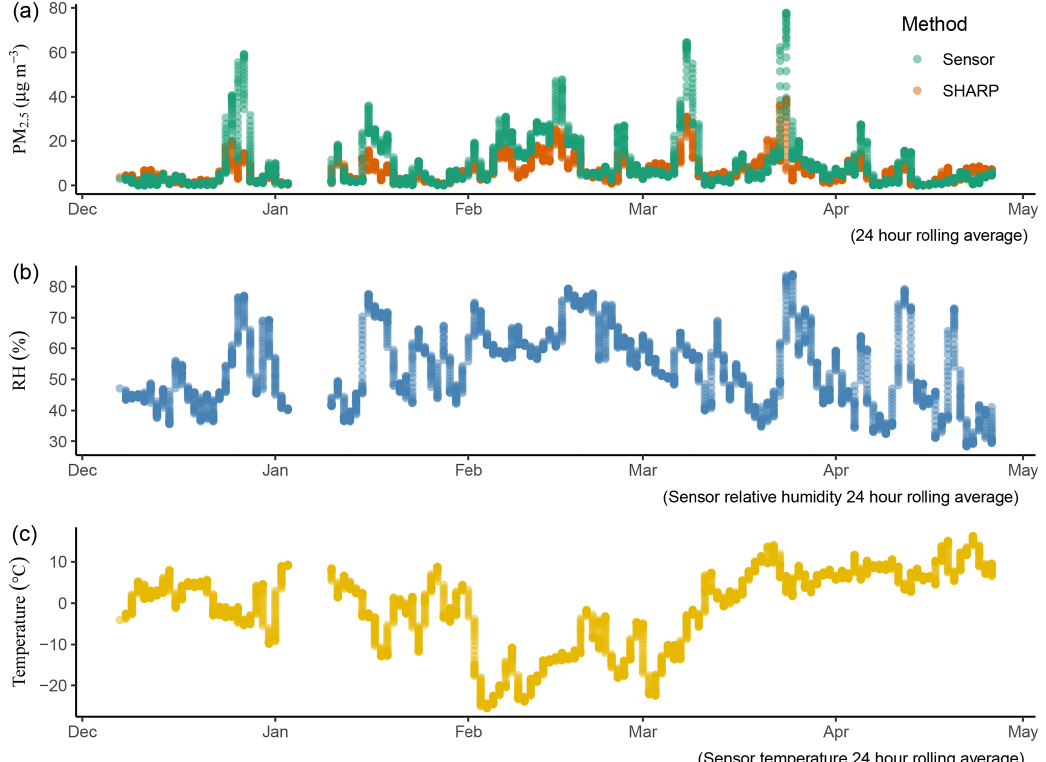
Figure 5. PM 2 . 5 , relative humidity, and temperature data on the basis of a 24h rolling average.